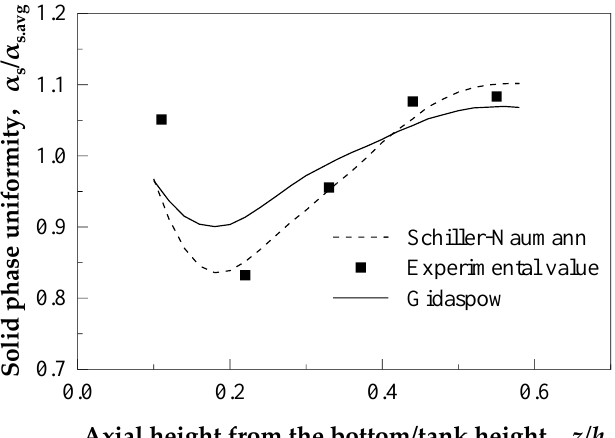
Figure 3. Comparison of experimental value of uniformity axial distribution with CFD value. velocity and the stirring speed are 2 m 3 /h, 0.0044 m/s and 200 rpm, respectively, according to [18]. The comparison results are shown in Figure 4. In the process of rising from the bottom of the reactor, the bubbles are broken into small bubbles after stirring, and then coalesce again to become larger diameter bubbles, so, the simulation can better describe the experimental results.